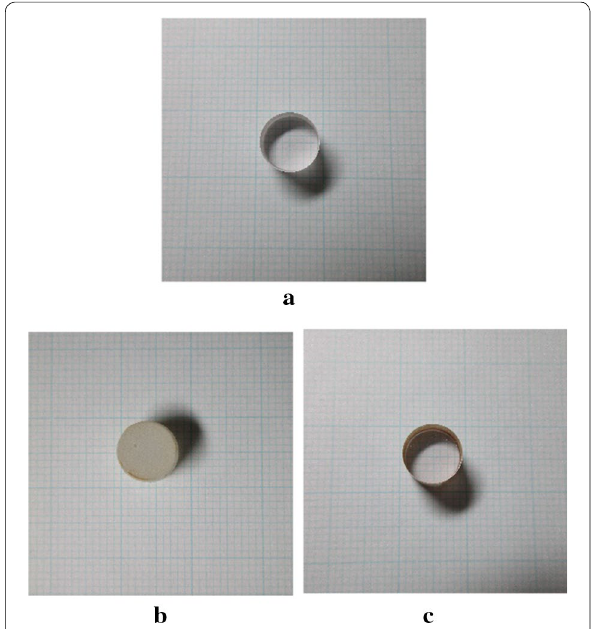
Fig. 4 Photographs showing the appearance of sapphire glass a before corrosion resistance test b after corrosion resistance test using NH 4 F mineralizer ( b ) after corrosion resistance test using NH 4 Cl mineralizer: corrosion resistance test conditions were 450 °C, 102 MPa, 2.0